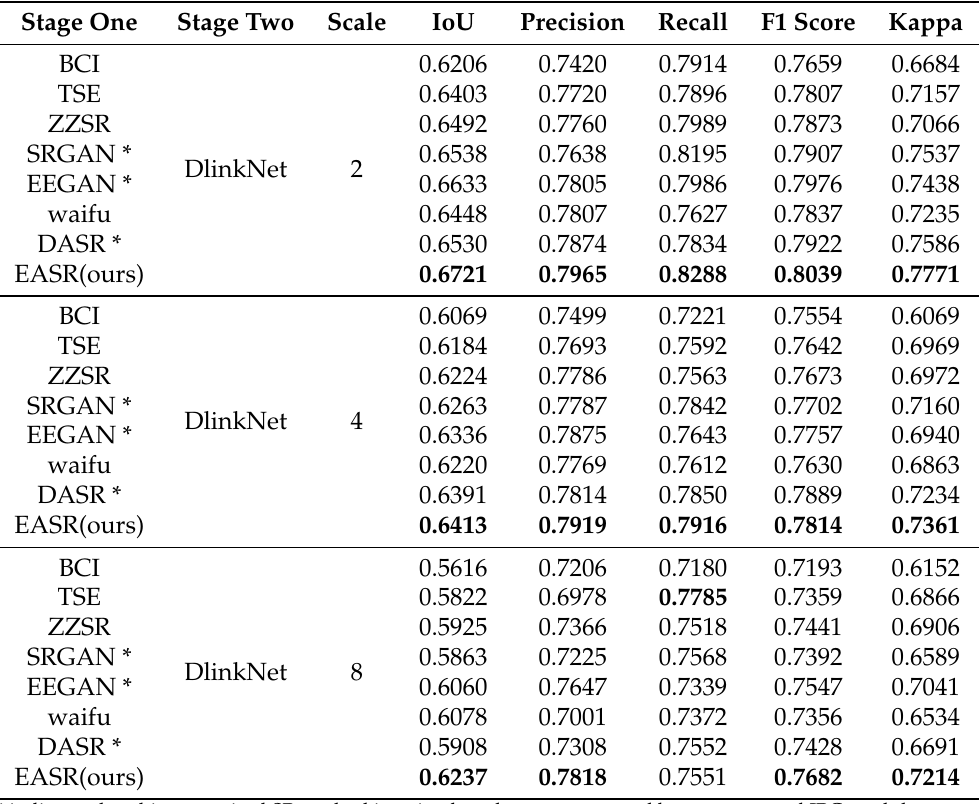
Table 1. Quantitative evaluation results on the super-resolution